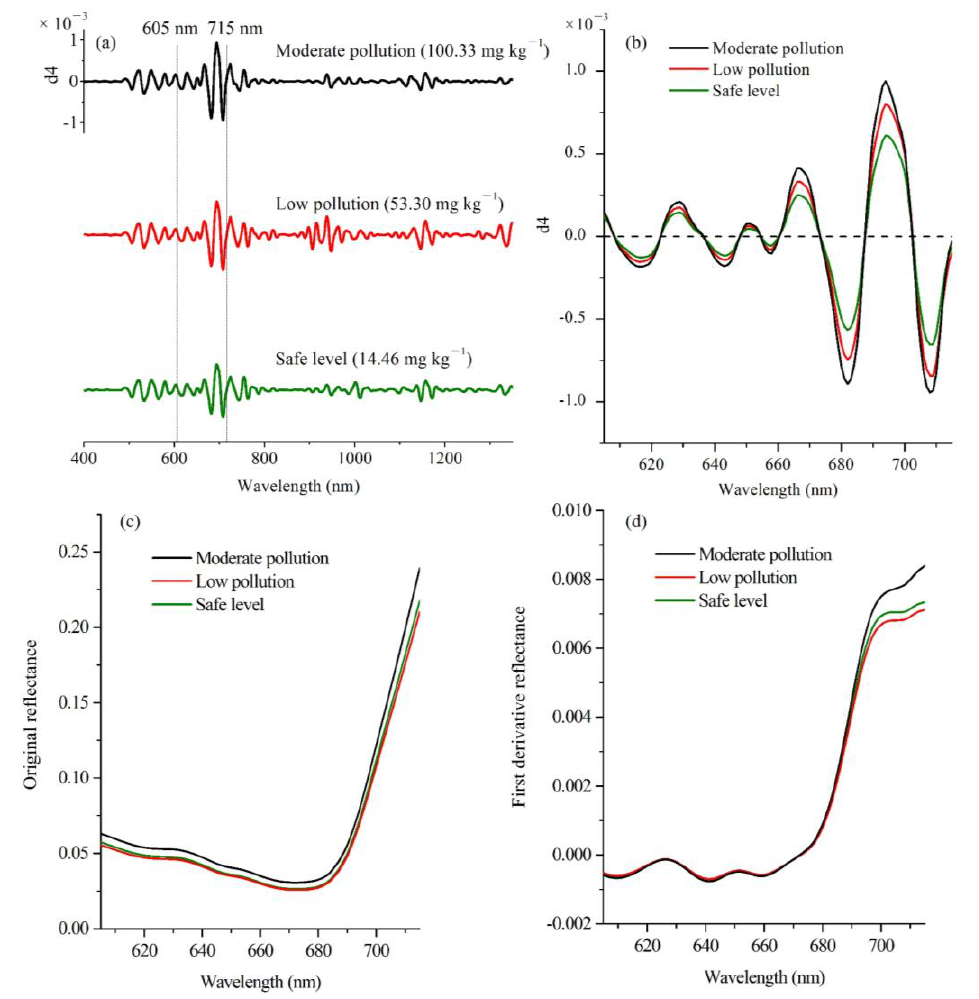
Figure 7. ( a ) The mean d4 reflectance (400−1350 nm), ( b ) the amplifying d4 reflectance (605−715 nm), ( c ) the mean original reflectance (605−715 nm), ( d ) the mean first